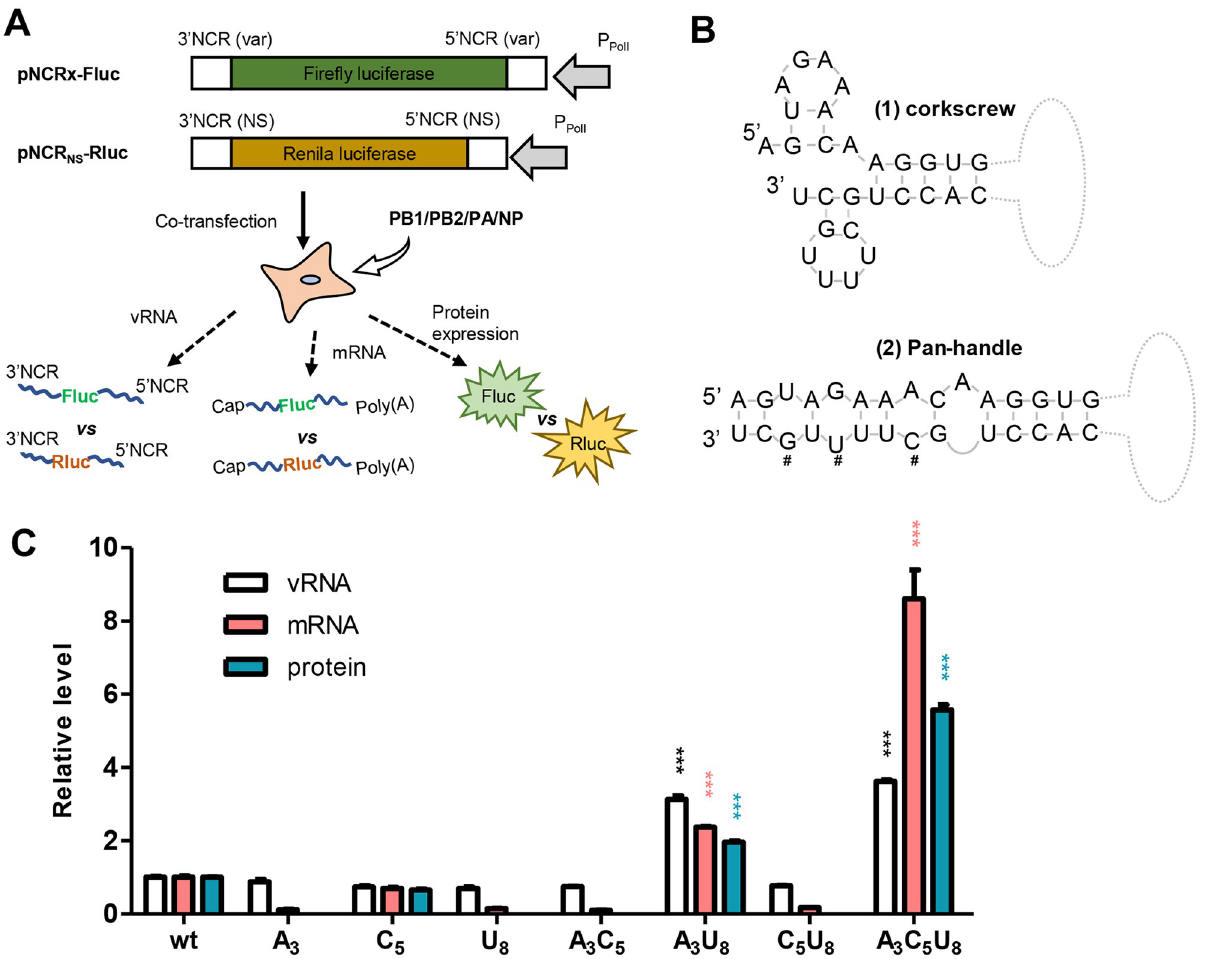
Fig 1. Pan-handle stabilizing mutations at the 3’-NCR enhances the transcription/replication of influenza vRNA. (A) A schematic overview of the dual-template reporter constructs and the cell-based dual-template RdRp assay. (B) Presentation of two of the proposed vRNA promoter structure models. #, indicates the pan-handle stabilizing mutation site. (C) Normalized ratio of firefly to Renilla luciferase (Fluc/Rluc) at the vRNA, mRNA as well as protein expression levels. ��� , p < 0.001, students’ t test.